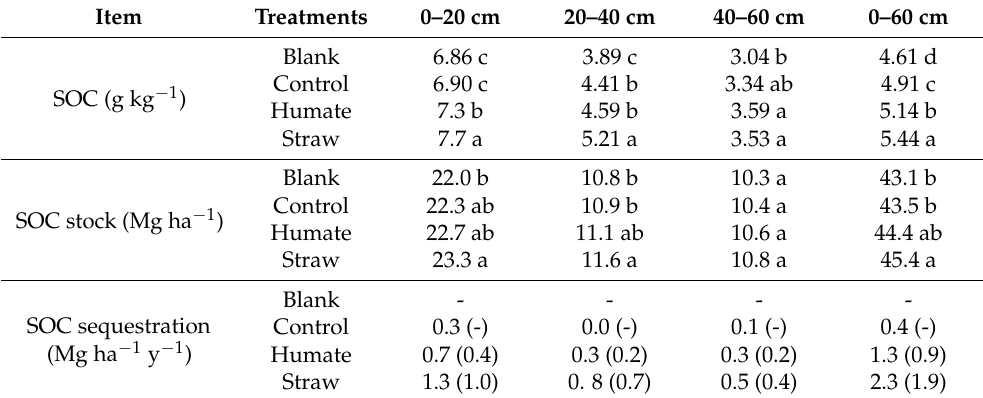
Table 2. Soil organic carbon (SOC) concentration, stock, and sequestration in 2018 after 3 years of